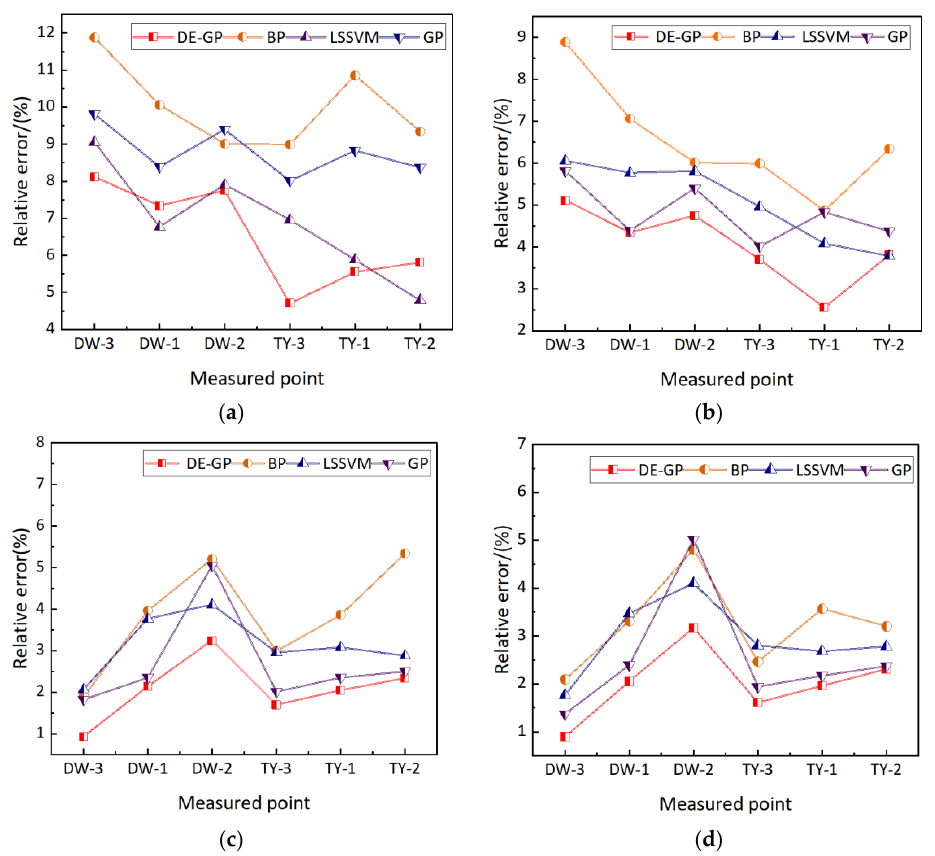
Figure 12. Relative error of monitoring point values of different strategies: ( a ) 5 samples; ( b ) 10 samples; ( c ) 25 samples; ( d ) 41 samples.